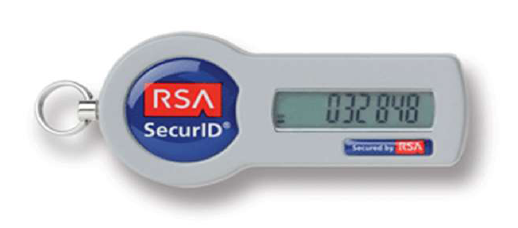
Figure 8-2: Security